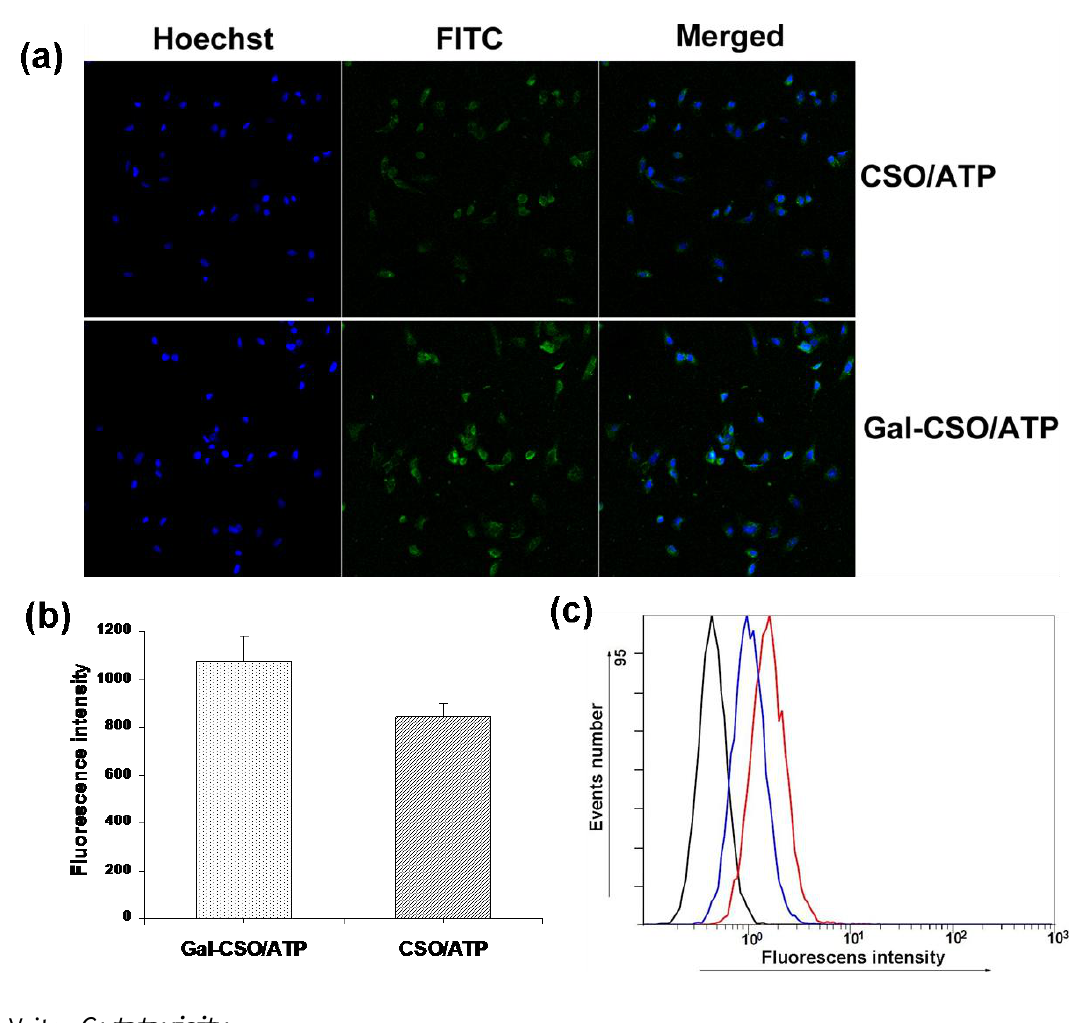
Figure 5. HepG2 cells were incubated with fluorescein isothiocyanate (FITC)-labeled Gal-CSO/ATP and CSO/ATP nanoparticles for 24 h, respectively. ( a ) Confocal laser scanning images; ( b ) the quantitative analysis based on the imaging in ( a ) by the software, “ImageJ”; and ( c ) quantitative cell uptake, analyzed by a flow-cytometer,